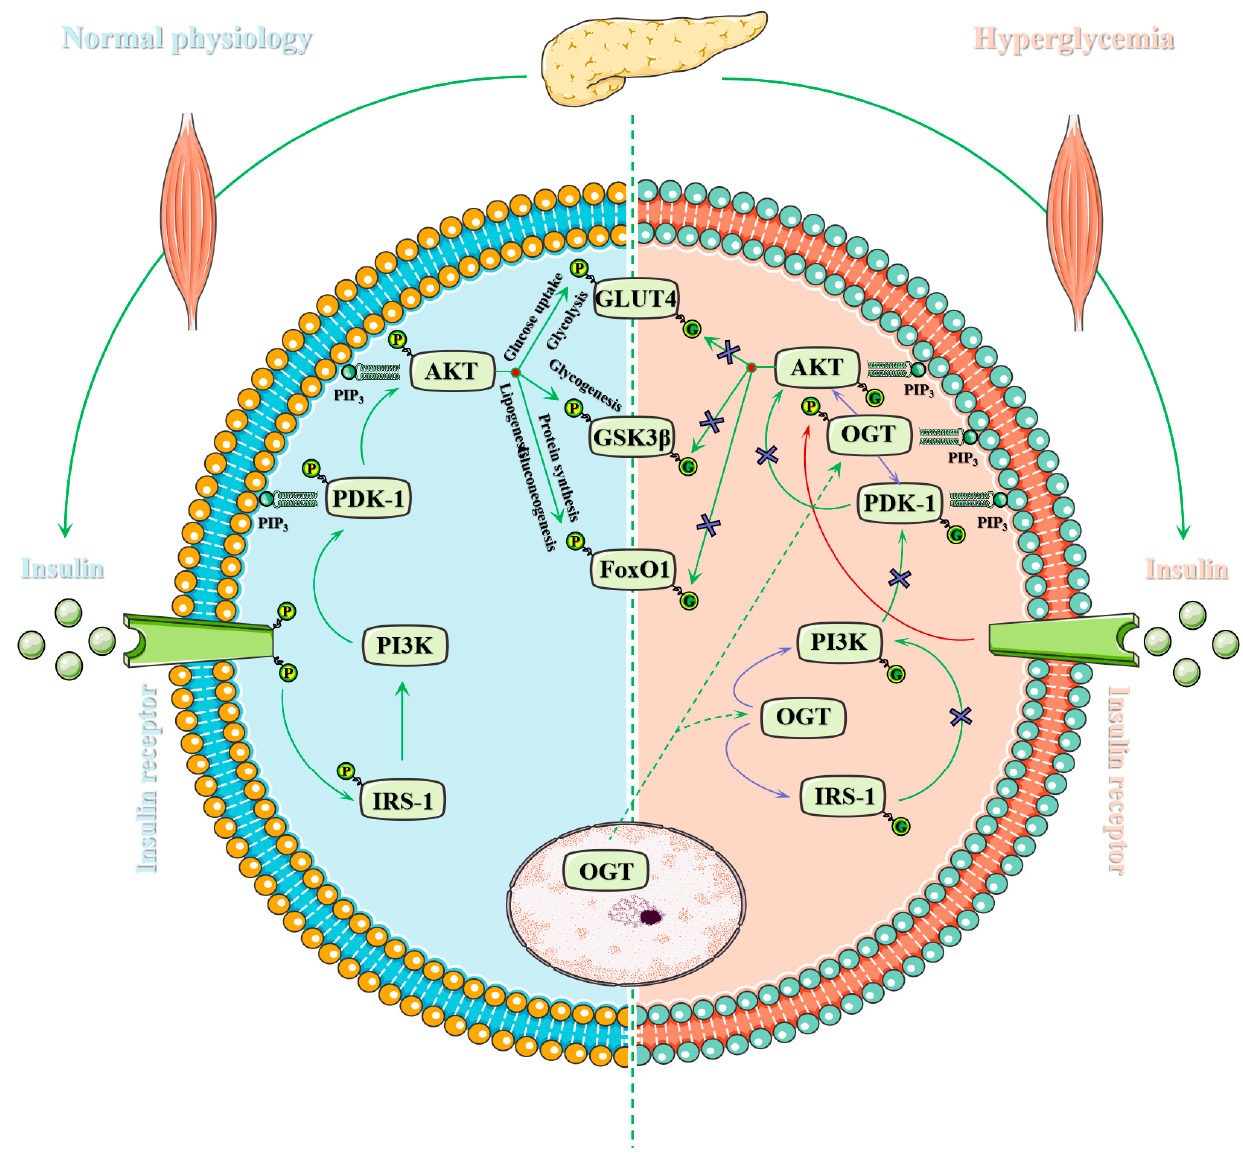
Figure 3. Spatiotemporal regulation of O -GlcNAcylation on insulin signal transduction of skeletal muscle. Skeletal muscle is the major insulin-sensitive tissue, responsible for about 75% of insulin- stimulated glucose uptake in the whole body, which is critical for glucose homeostasis and energy metabolism. The harmonious balance between O -GlcNAcylation and phosphorylation is necessary for the normal operation of insulin signaling under normal physiology, and the disruption of this homeostasis leads to the impairment of insulin-signaling cascade. O -GlcNAcylation has been described as protecting cells from acute stress but harmful to chronic and persistent stress in various organs or tissues. For example, almost all insulin-sensitive tissues have a hyper O -GlcNAcylation level and many related complications are under hyperglycemia. This adverse effect is achieved through impaired glucose utilization or glucose toxicity paradigms and may lead to the progression of a variety of diseases. Therefore, chronic elevation of O -GlcNAcylation is considered as a mechanism for the development of insulin resistance.